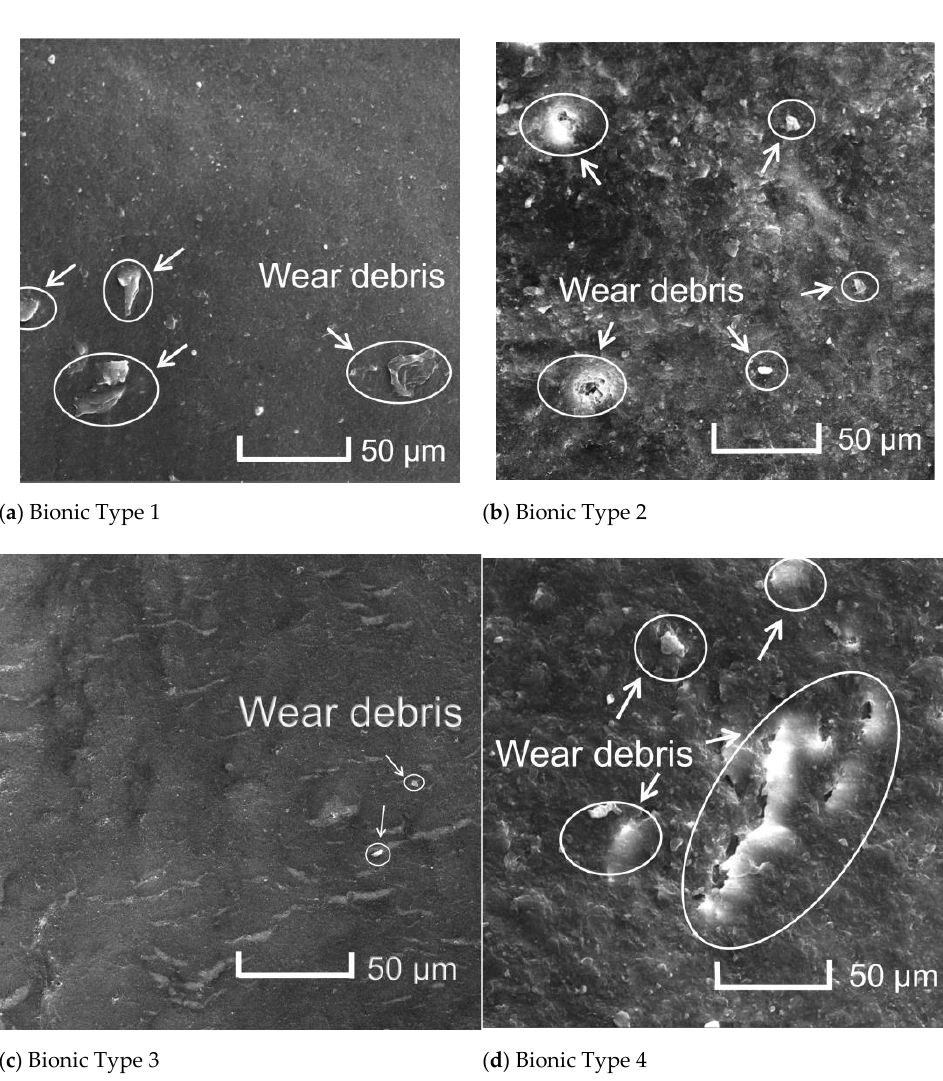
Figure 9. Surface wear patterns of different bionic geometrically structured surfaces.